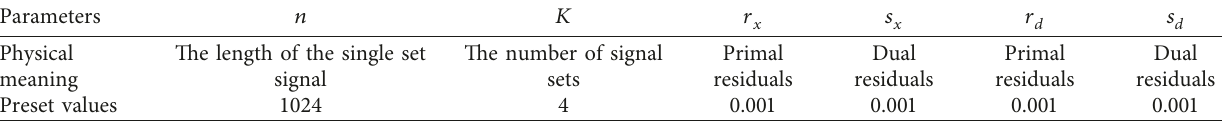
Table 1: Boundary condition-related parameters.